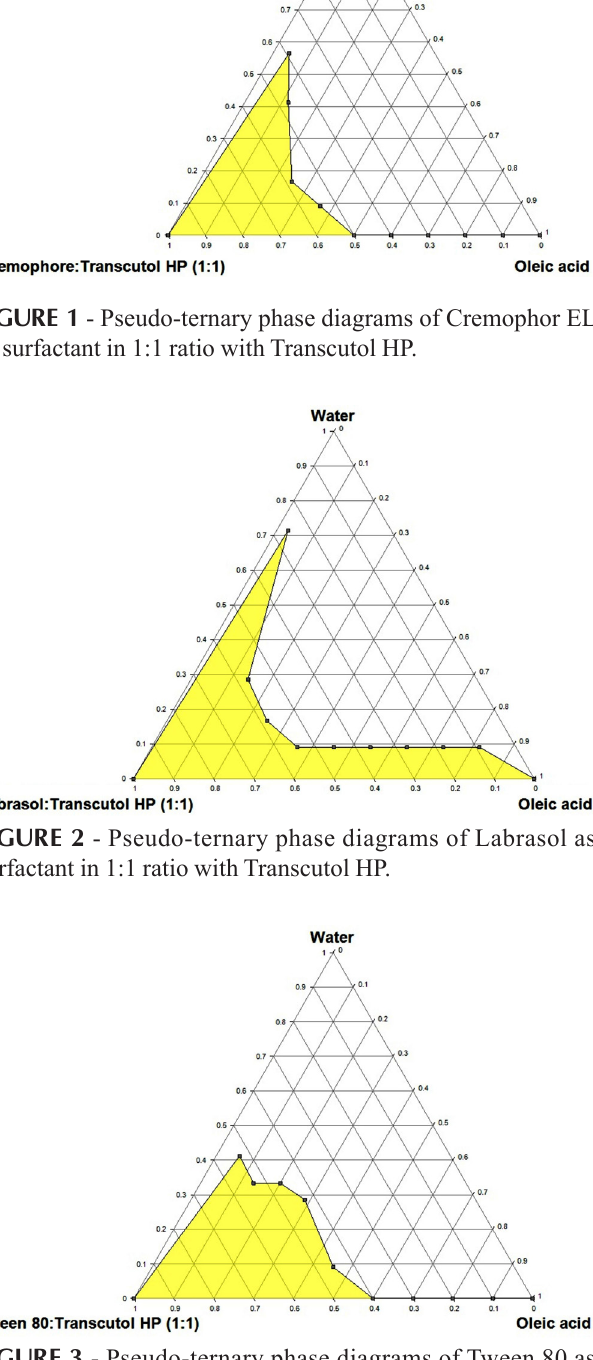
FIGURE 3 - Pseudo-ternary phase diagrams of Tween 80 as surfactant in 1:1 ratio with Transcutol